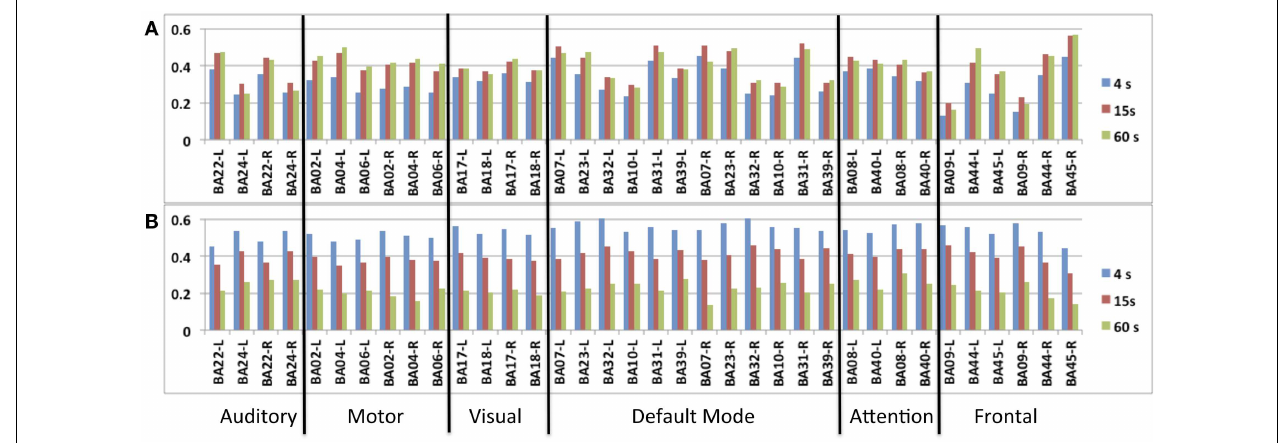
FIGURE 7 | Seed-based intra-network FNC at the end of the scan averaged across nine healthy subjects using MEVI2 (TR: 136ms) . Spatial means of the meta-statistics (A) means and (B) standard deviation in a subset of 18 selected Brodmann areas as a function of sliding-window width (4, 15, and 60s).